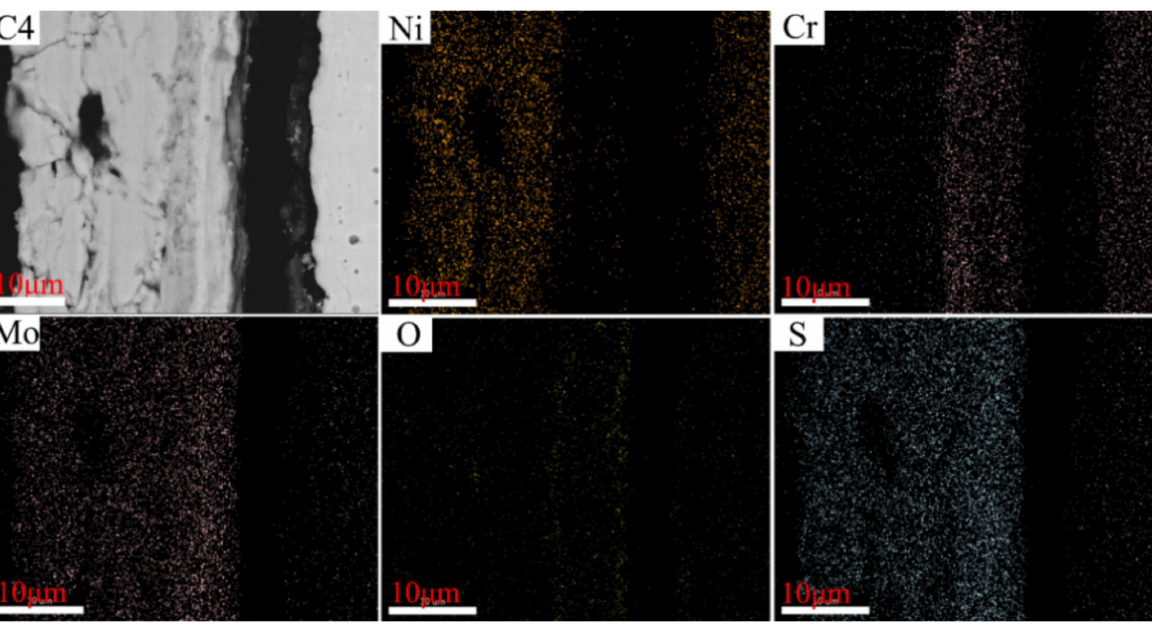
Figure 15. EDS maps of C4 cross-section after the sulfur corrosion test at 550 ◦ C for 168